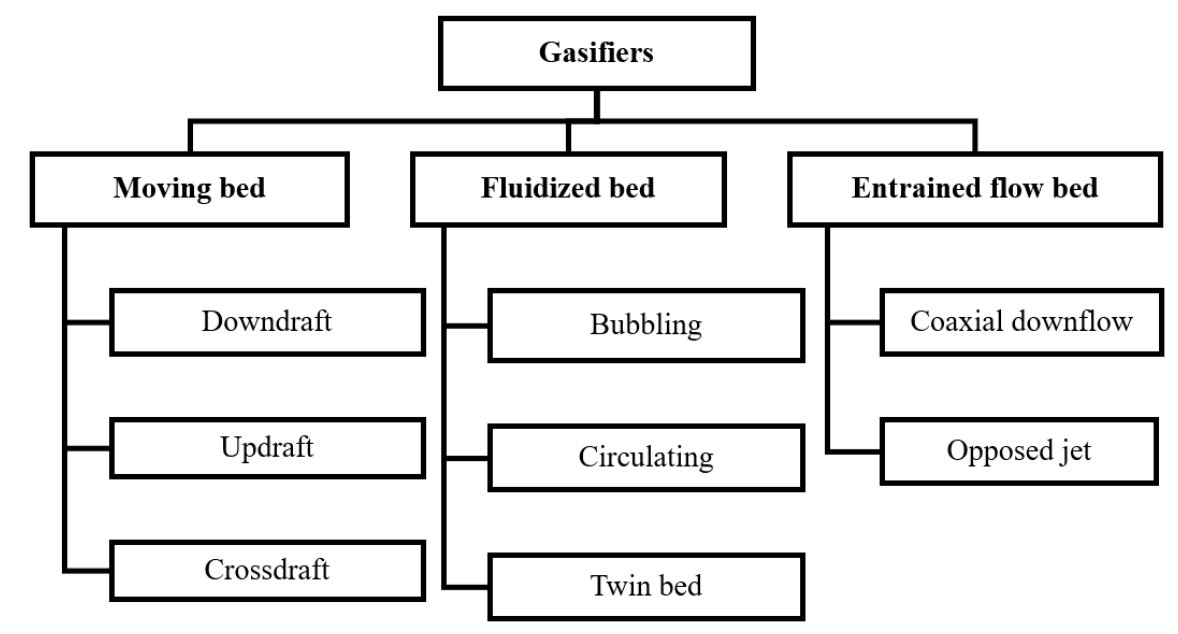
Figure 3. Classi fi cation of gasi fi ers . Figure 3. Classification of